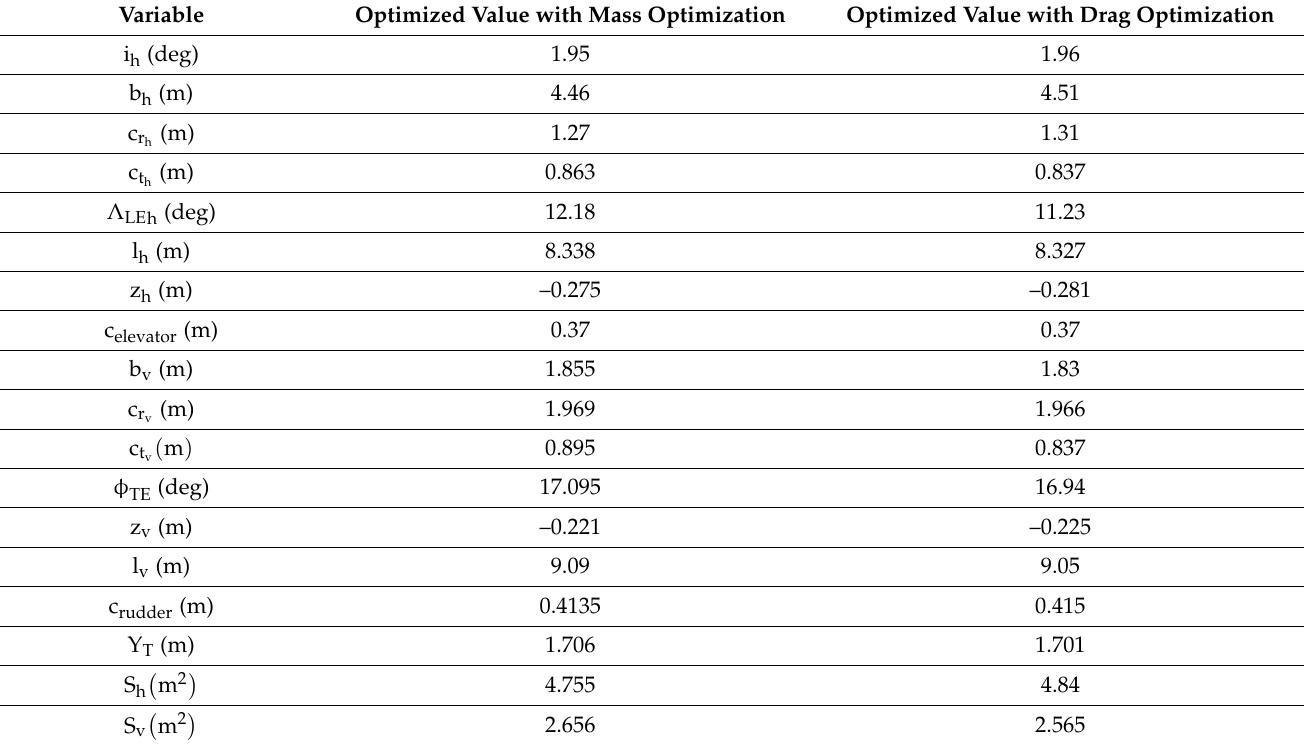
Figure 7. ( a ) The optimized empennage configuration considering the corresponding constraints and uncertainties; ( b ) the total aircraft presentation using MAPLA’s geometry module for the optimized empennage configuration. Table 5. Optimized design variables for empennage sizing of the twin-engine